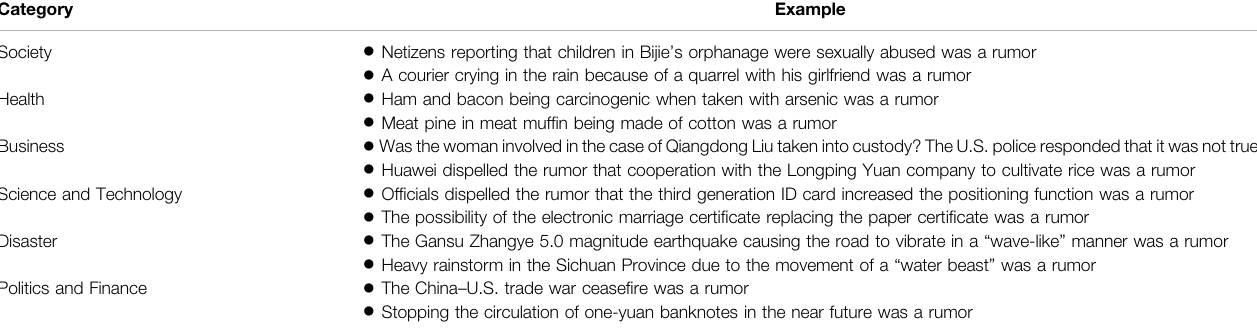
TABLE 3 | Examples for six categories of fake news (Translated into English from Chinese).